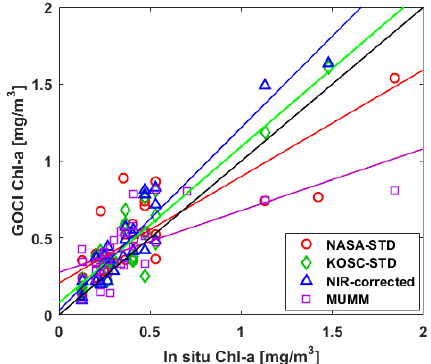
Figure 9. Scatterplots of GOCI Chla retrieved by the four algorithms versus in situ Chla at 02:16, 03:16, and 04:16 UTC within a ± 3 h match-up time. Symbols are the same as described in Figure 4.